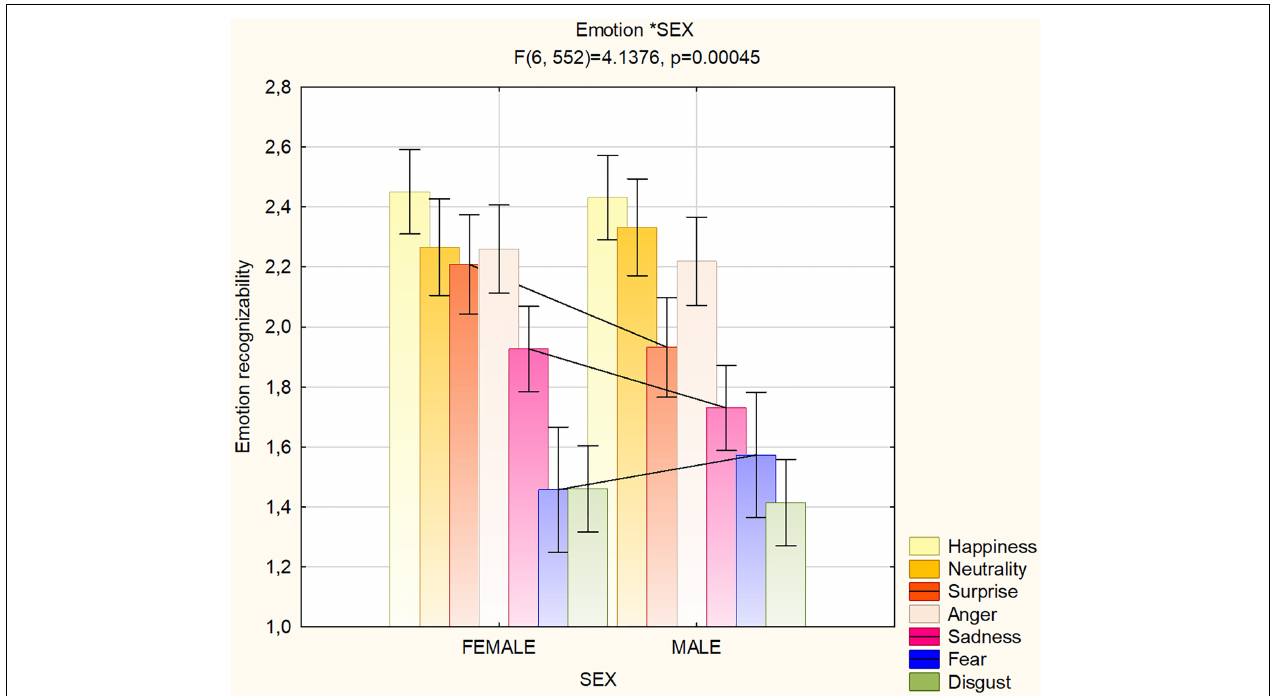
FIGURE 4 | Mean scores of recognizability (along with SE values) attributed by female and male participants ( N = 94) to the various facial expressions as a function of masking condition.